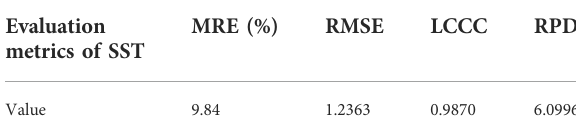
TABLE 7 Evaluation metrics of SST prediction results in